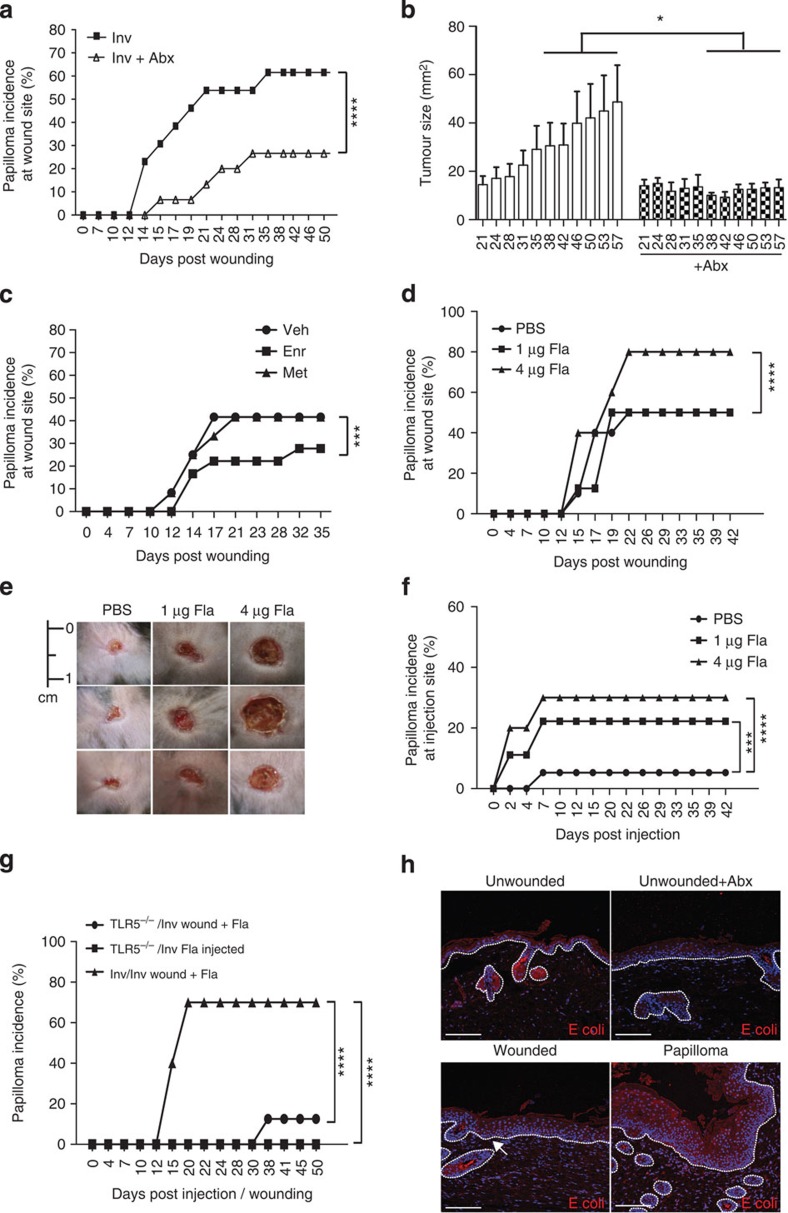
Microbial products promote tumour formation in InvEE mice.(a,c,d,f,g) Incidence of papilloma formation following wounding (a,c,d,g) or intradermal injection (f,g). (a) Mice were untreated (n=13) or treated with orally administered enrofloxacin (Enr) antibiotic (n=15) starting 8 days before wounding (P<0.0001; Fisher’s exact test). (b) Tumour growth in untreated (n=8) and oral antibiotic-treated (n=4) mice (*0.01<P<0.05; unpaired t-test). Data are means±s.e.m. (c) Mice were treated topically with vehicle (Veh; acetone; n=12), Enr (n=21) or methicillin (Met; n=12; ***0.0001<P<0.001; one-way analysis of variance (ANOVA)). (d) PBS (n=10), 1 μg flagellin (Fla; n=8) or 4 μg Fla (n=10) was applied in wound at time of wounding (****P<0.0001; one-way ANOVA). (e) Wounds treated with flagellin or PBS were photographed 7 days after wounding. (f) Papilloma incidence in mice that received intradermal injections of PBS (n=19), 1 μg Fla (n=8) or 4 μg Fla (n=10; ***0.0001<P<0.001; one-way ANOVA). (g) Papilloma incidence in TLR-5−/− BM chimeras (n=8) and control (n=10) chimeras that were wounded or injected (n=10) with 4 μg Fla (***0.0001<P<0.001; one-way ANOVA). (h) Immunofluorescence labelling of InvEE skin with antibody to flagellated E. coli K12 strain. Wounded skin was collected 17 days after wounding. Unwounded skin was either untreated or treated (+Abx) for 8 days with oral Enr. Dotted line represents epidermal–dermal boundary. Scale bars, 300 μm.